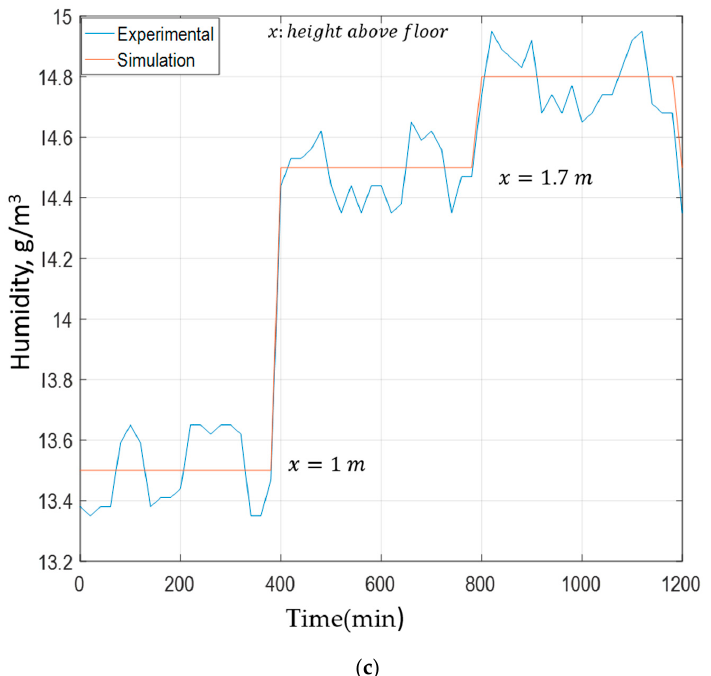
Figure 10. ( a ) Experimental results of air velocity. ( b ) Experimental results for temperature. ( c ) Experimental results for RH.